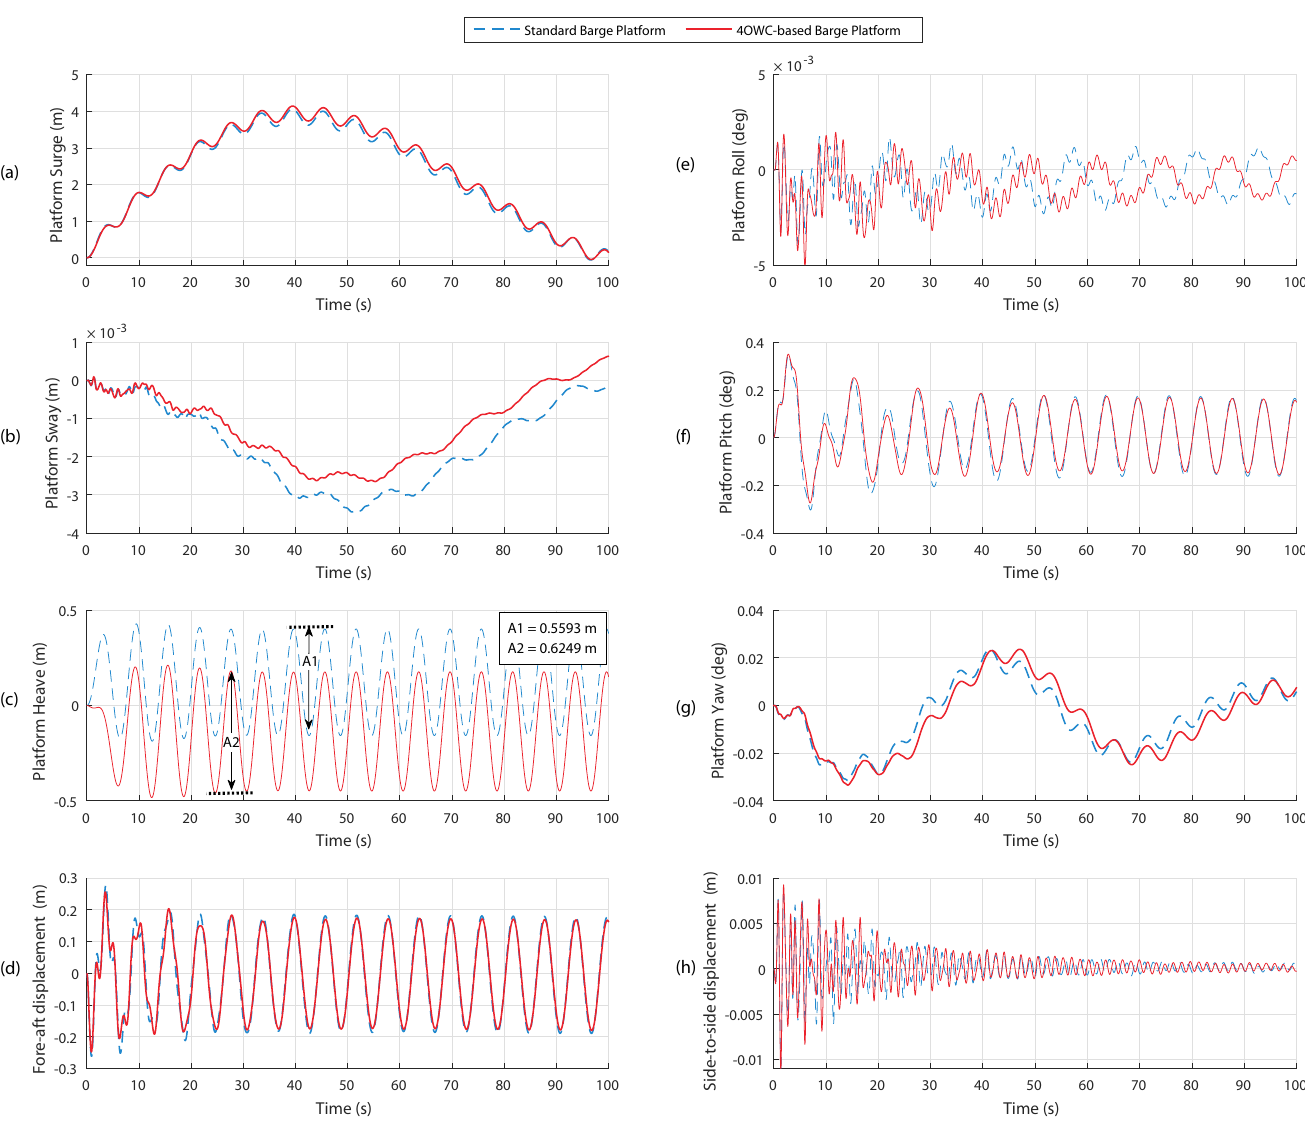
Figure 8. Platforms’ modes for ( a ) Surge. ( b ) Sway. ( c ) Heave. ( d ) Fore-aft. ( e ) Roll. ( f ) Pitch. ( g ) Yaw. ( h ) Side-to-side.